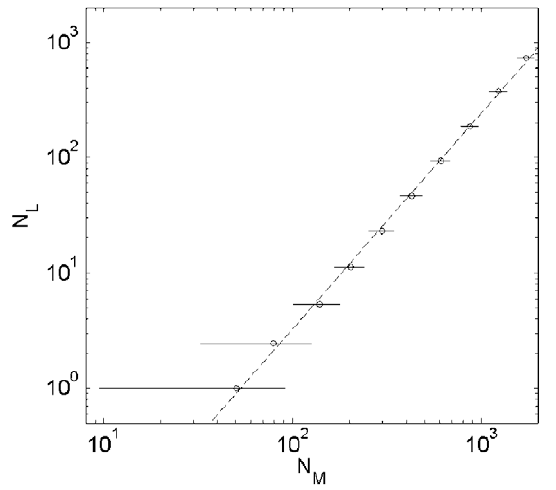
Figure 2. N L vs. N M . N L is the number of leaves in an organism- specific metabolic network and equal to the number of transcriptional regulators of corresponding nutrient-utilizing pathways, while N M is the total number of nodes/metabolites in this netowrk. The data are generated by the toolbox model on critical universal network with sizes = A , where the exponent a ~ 1 : 9 + 0 : 1 around 2000. Solid line N L ~ N a M and the prefactor A ~ 1600 + 400 , are the best fits to the binned data.